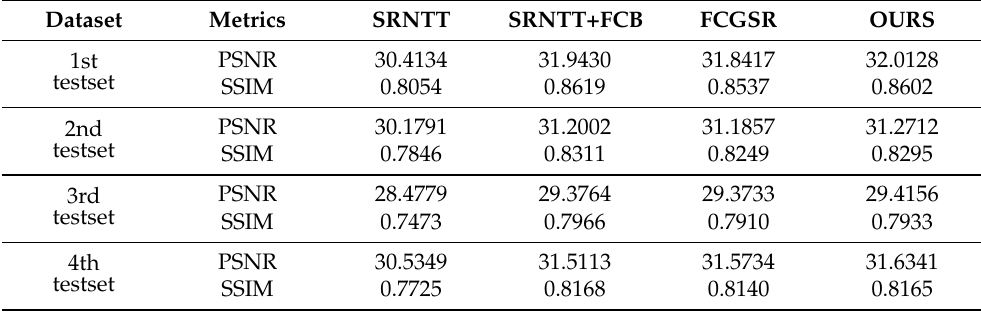
Table 4. Average PSNR and SSIM results for four different models of ×4 factor on four test